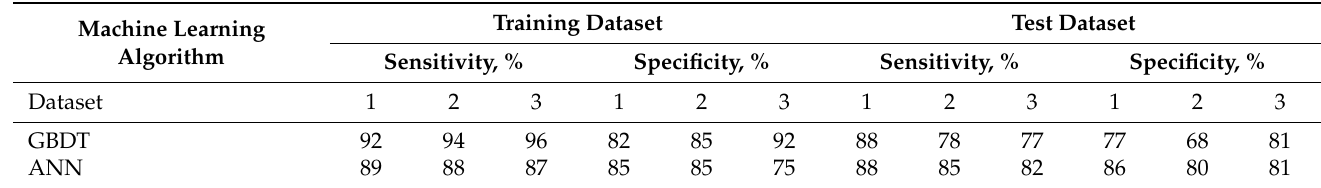
Table 7. Accuracy of diagnostic models.